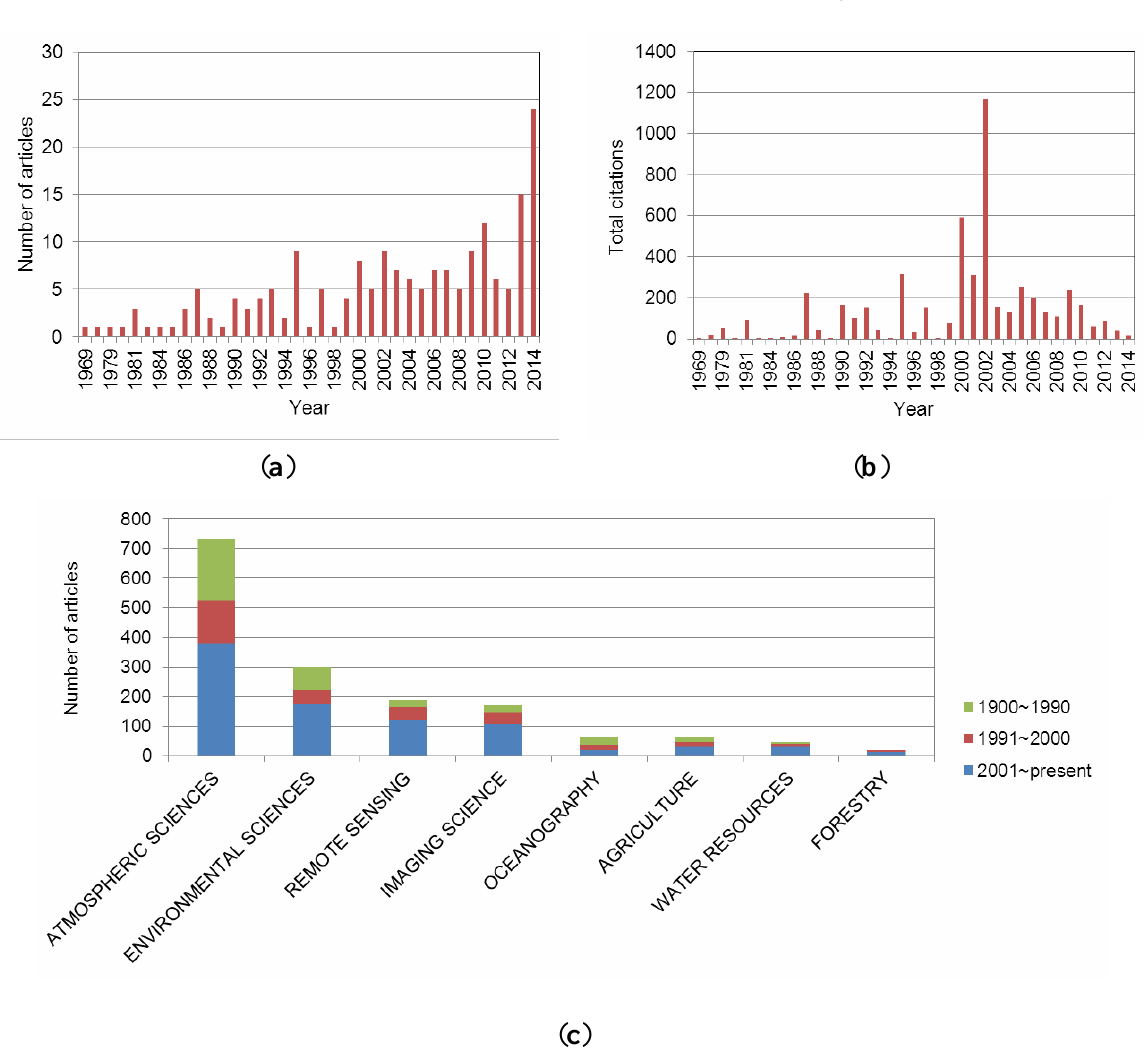
Figure 2. Citation statistics of mapping surface broadband albedo from satellite data. ( a